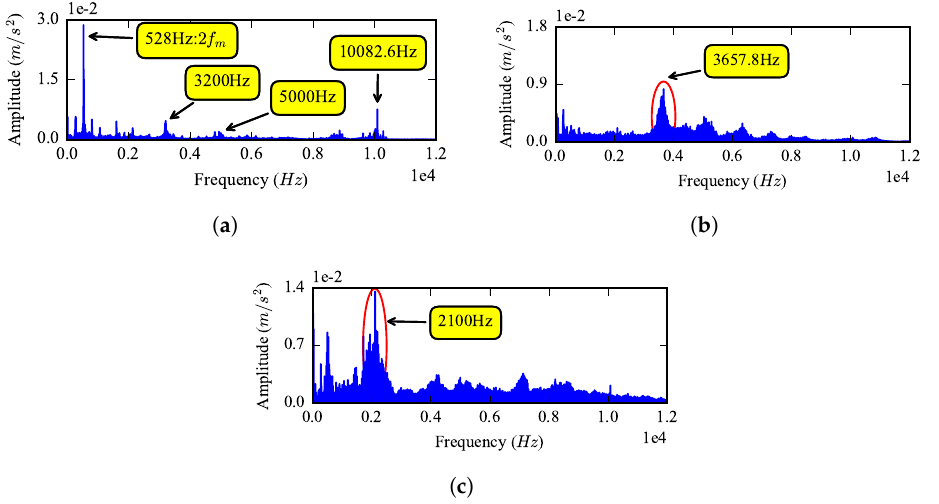
Figure 14. Spectrum of the experimental ring vertical acceleration of the ( a ) healthy gear, ( b ) half tooth breakage fault gear and ( c ) the whole tooth breakage